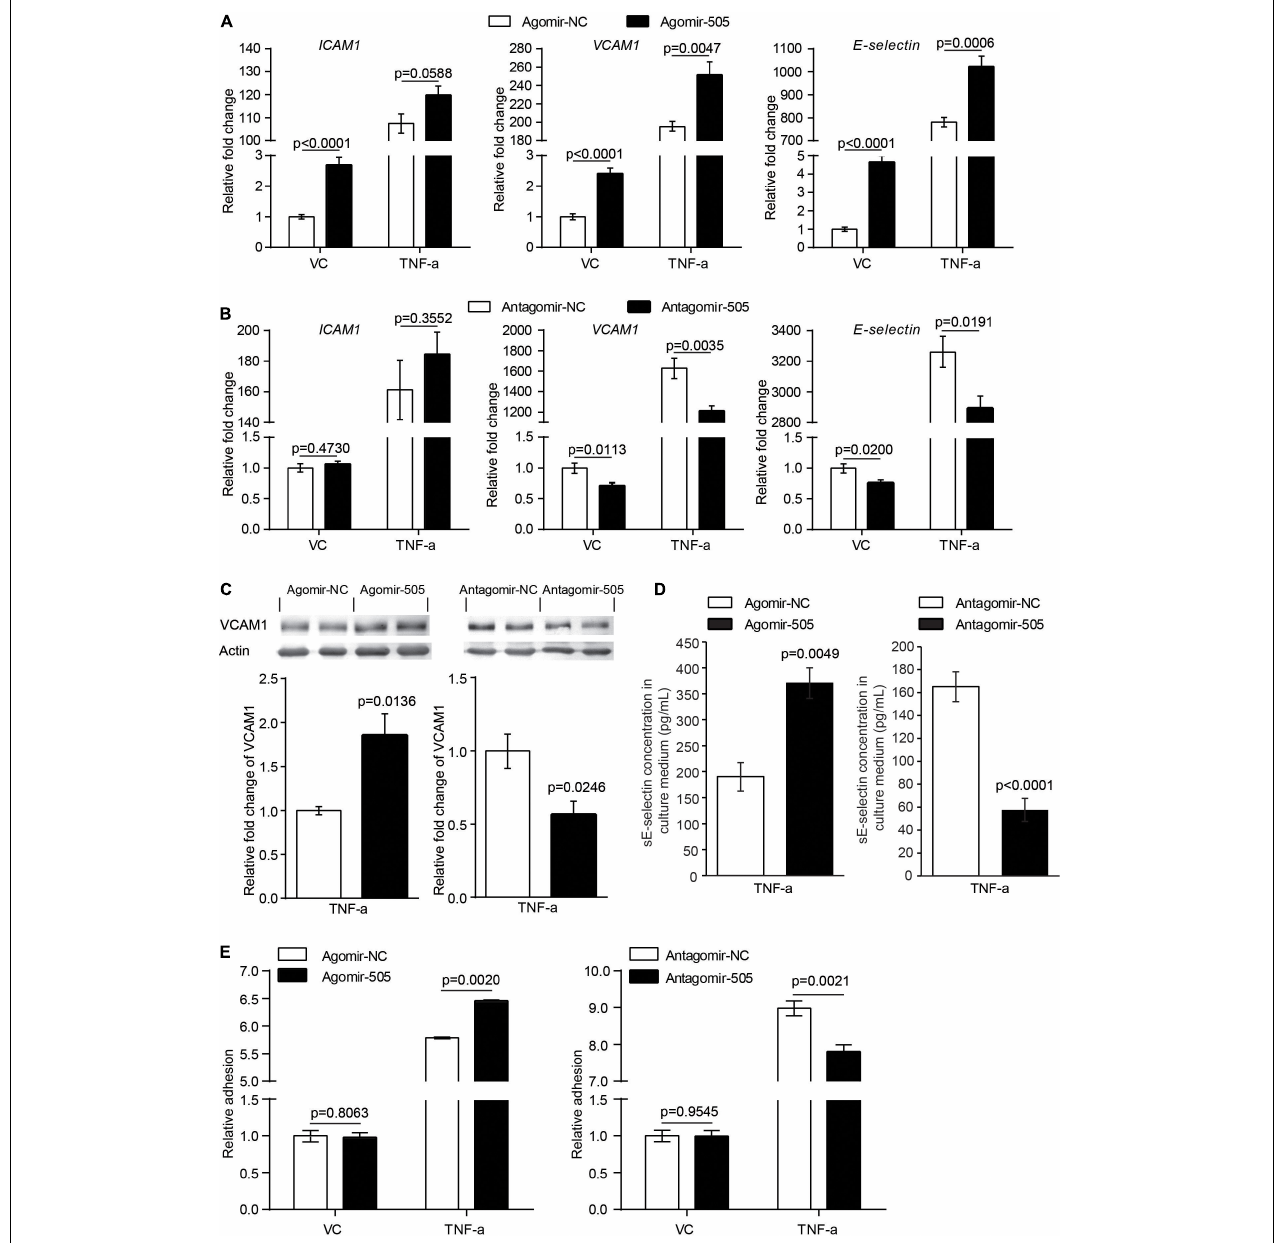
FIGURE 6 | MiR-505 promotes endothelial activation. (A) Agomir-505-transfected and agomir-NC-transfected HUVECs were exposed to vehicle (VC) or 2 ng/mL TNF- α for 16 h, followed by real-time qPCR analysis of the expression of ICAM1 , VCAM1 and E-selectin . Relative fold change of gene expression was plotted against that from agomir-NC-transfected vehicle-treated cells ( n = 6 per group). Data represent mean ± SEM. P values are derived from one-way ANOVA and the Student’s t -test. (B) Antagomir-505-transfected and antagomir-NC-transfected HUVECs were treated with vehicle or 2 ng/mL TNF- α for 16 h, followed by real-time qPCR analysis of the expression of ICAM1 , VCAM1 and E-selectin . Relative fold change of gene expression was plotted against that from antagomir-NC-transfected vehicle-treated cells ( n = 6 per group). Data represent mean ± SEM. P values are derived from one-way ANOVA and the Student’s t -test. (C) Agomir-505, antagomir-505 and their respective negative controls were transfected in HUVECs, followed by vehicle or 2 ng/mL TNF- α treatment for additional 16 h. The protein level of VCAM1 was then examined by western blotting. Relative fold change of VCAM1 protein was plotted against that from agomir-NC-transfected TNF- α -stimulated cells or antagomir-NC-transfected TNF- α -stimulated cells ( n = 4 per group). Data represent mean ± SEM. P values are derived from the Student’s t -test. (D) HUVECs were transfected with agomir-505, antagomir-505 and their respective negative controls, followed by vehicle or 2 ng/mL TNF- α treatment for 12 h. The culture medium was then collected and analyzed for the level of sE-selectin by ELISA ( n = 6 per group). Data represent mean ± SEM. P values are derived from the Student’s t -test. (E) Agomir-505, antagomir-505 and their respective negative controls were transfected in HUVECs, followed by vehicle or 2 ng/mL TNF- α treatment for additional 16 h. The adhesion of CMFDA-labeled THP-1 cells to HUVECs was then examined by measuring the fluorescence intensity of CMFDA. Relative fold change of adhesion was plotted against that from agomir-NC-transfected vehicle-treated cells or antagomir-505-transfected vehicle-treated cells ( n = 6 per group). Data represent mean ± SEM. P values are derived from one-way ANOVA and the Student’s t -test.